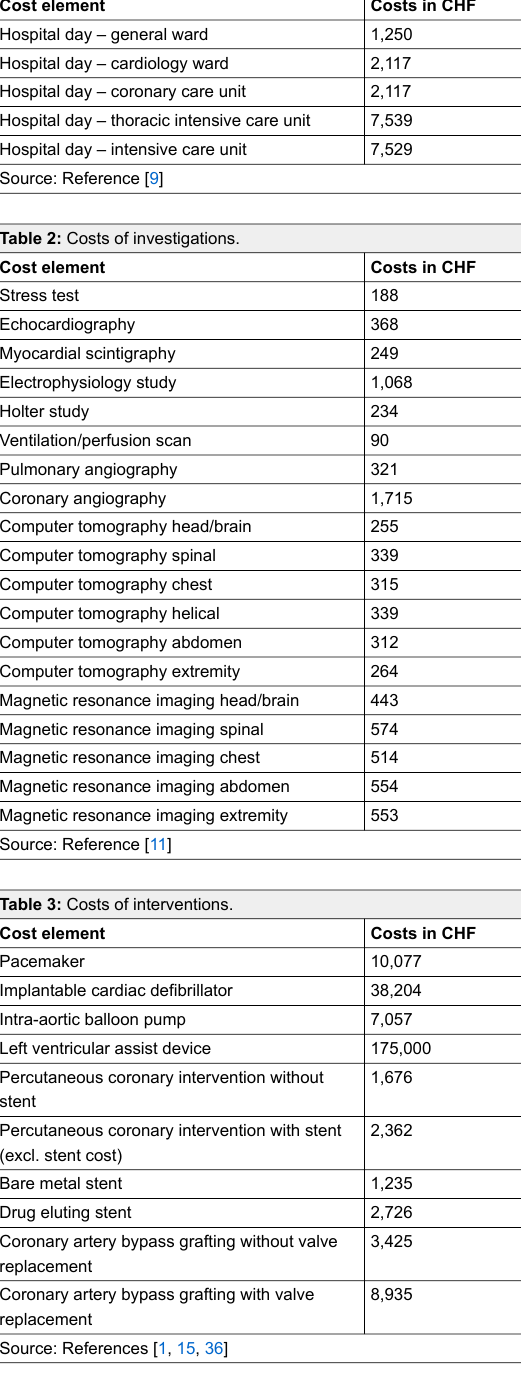
Table 1: Hospital day costs.